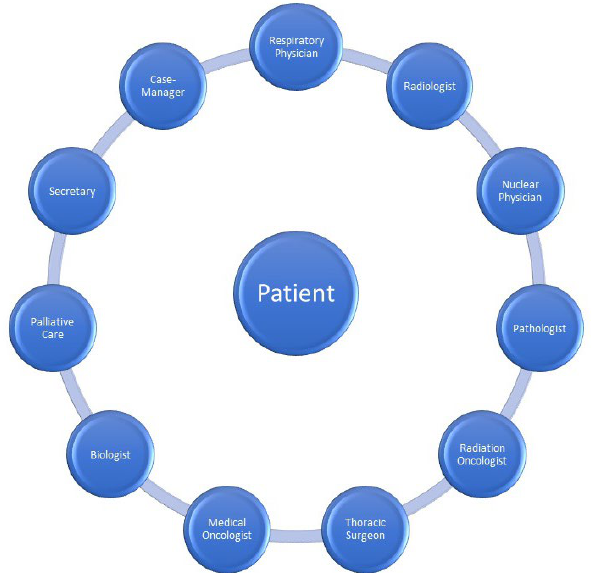
Figure 1. All the specialists contribute to the interdisciplinary management of lung cancer.